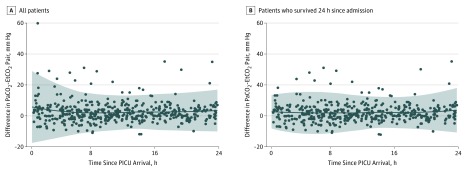
Paired Differences Between Partial Pressure of Carbon Dioxide, Arterial (Paco2) and End-Tidal Carbon Dioxide (EtCO2) by Hours Since Pediatric Intensive Care Unit (PICU) AdmissionA, Circles represent 445 Paco2-EtCO2 pairs for all 137 patients. B, Circles represent 420 Paco2-EtCO2 pairs for the 127 patients who survived 24 hours since PICU admission. Solid line indicates mean difference between Paco2 and EtCO2 by hour since PICU admission. Sharded areas indicate 95% prediction interval of the mean difference between Paco2 and EtCO2.